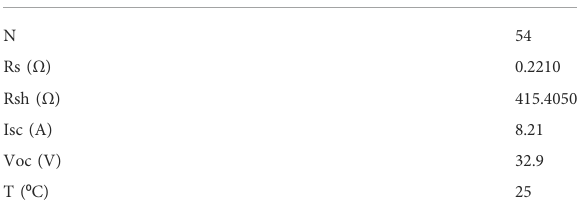
TABLE 1 PV module